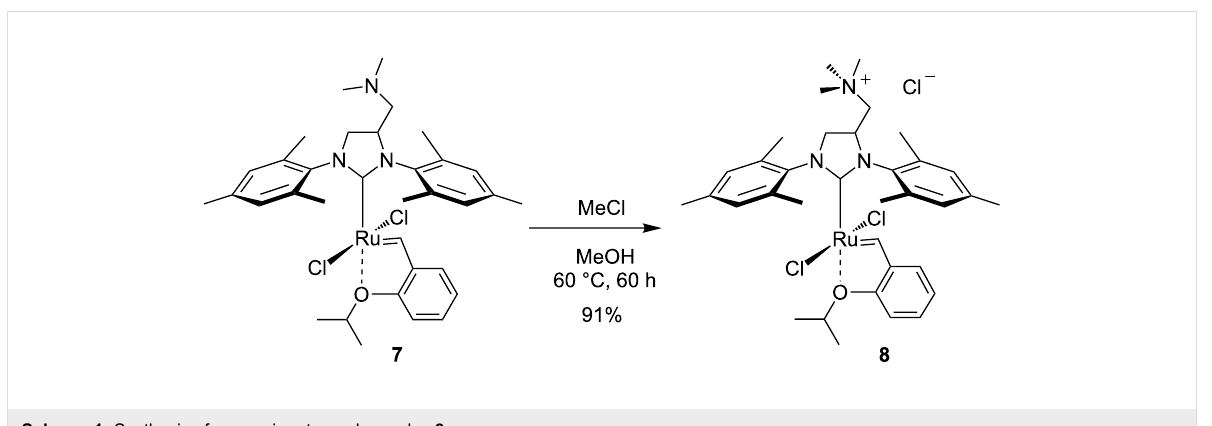
Scheme 1: Synthesis of ammonium-tagged complex 8 .